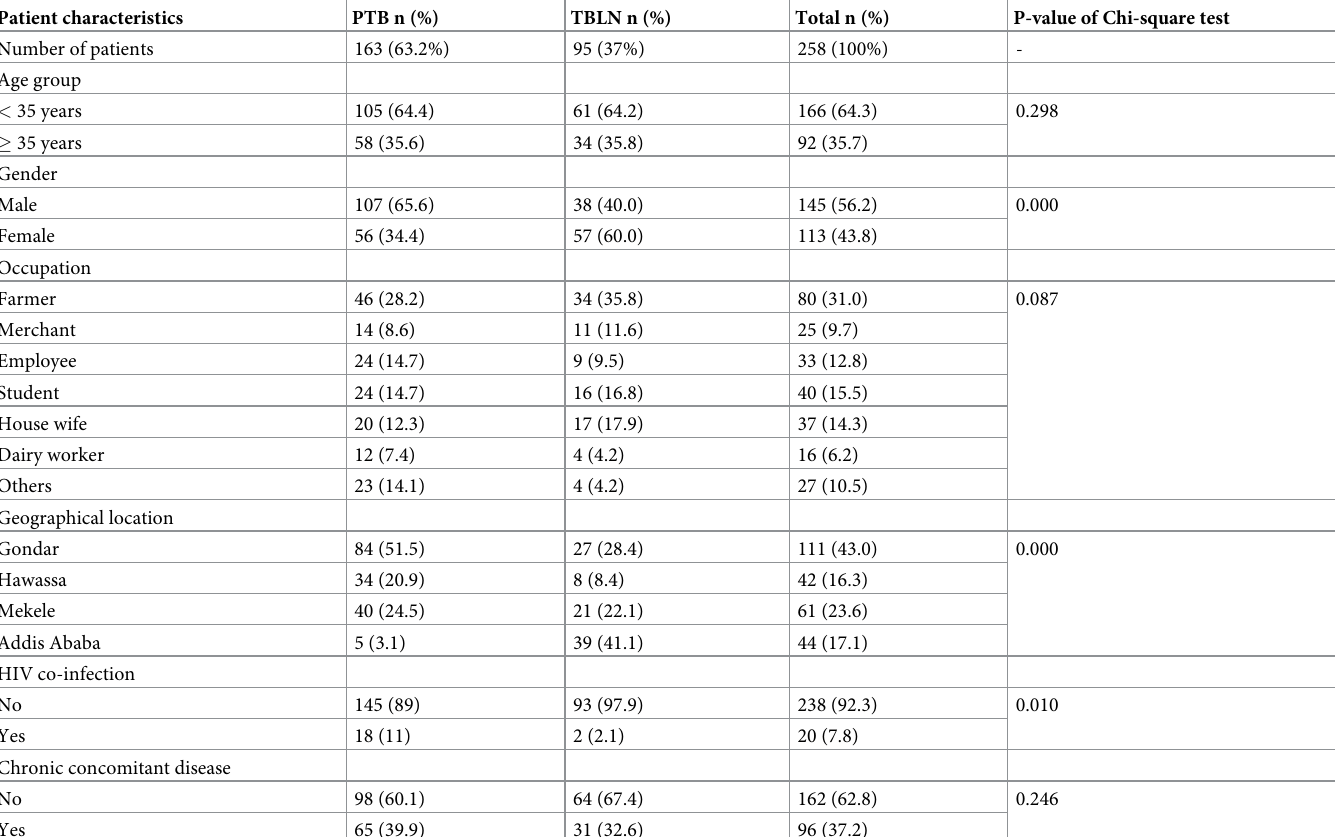
Table 1. Characteristics of the 258 study participants, 163 patients with pulmonary TB and 95 with cervical TB lymphadenitis, recruited at selected health facilities located in urban and peri-urban areas of Ethiopia in the years 2016/17. Patient